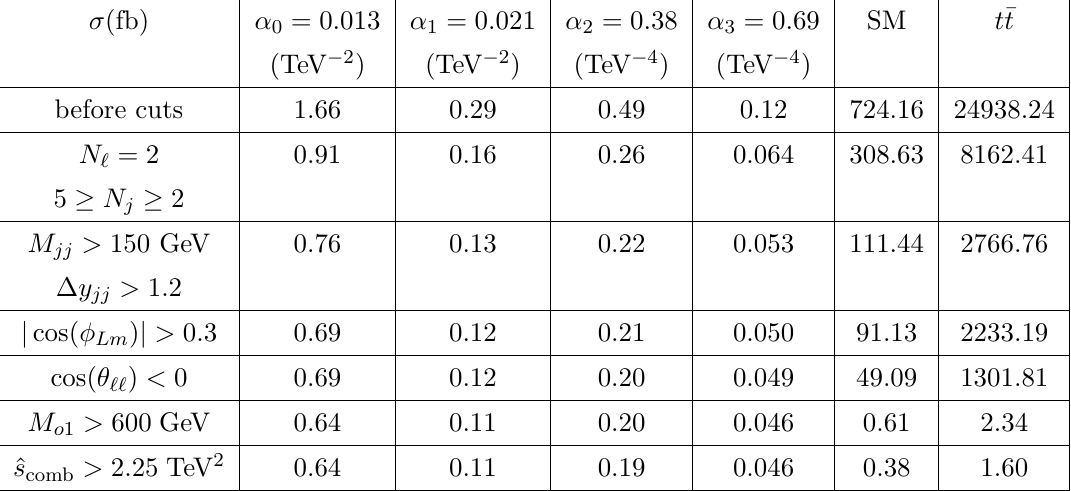
Table 2 . The effect of the cuts on the process pp → ‘ + ‘ − ν ¯ νjj . The cross sections of signal and background events are given in fb. The result of t ¯ t + Nj with N = 0 is shown as an example, the effect of b -tagging is not included in this table which will reduce the cross-section from 24938 . 24 fb to 1319 . 23 fb with 77% b -tagging